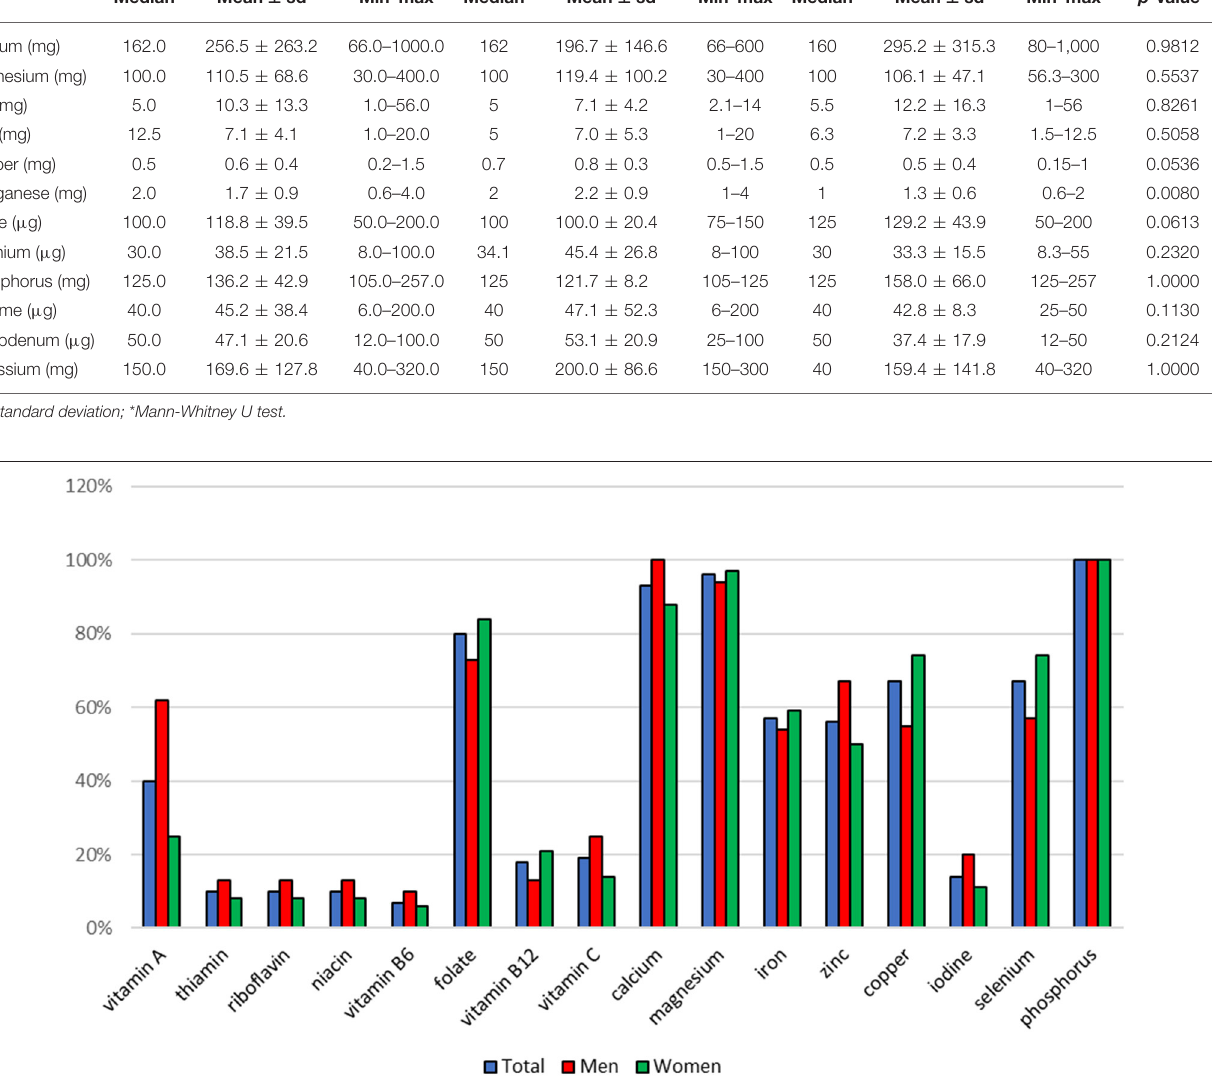
differences in data may be due to the fact that some